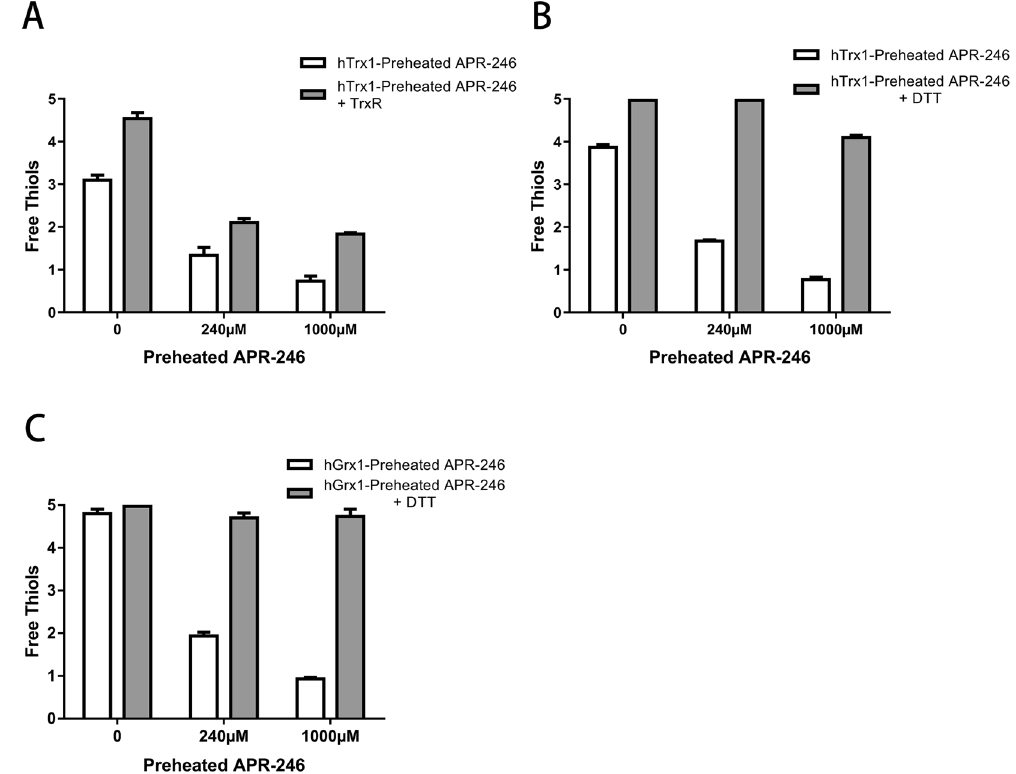
Figure 3. Efficient inhibition of Trx1 and Grx1 by preheated APR-246 is thiol-dependent and reversible. Indicated concentrations of preheated APR-246 efficiently inhibited 20 µ M fully reduced Trx1 and the inhibition was significantly reversed by incubation with ( A ) 50 nM TrxR or ( B ) 10 mM DTT. ( C ) Inhibition of 20 µ M Grx1 is significantly reversed upon incubation with 10 mM DTT. Amount of free thiols was determined with the DTNB assay 49 . Results are the means ± SEM (n =